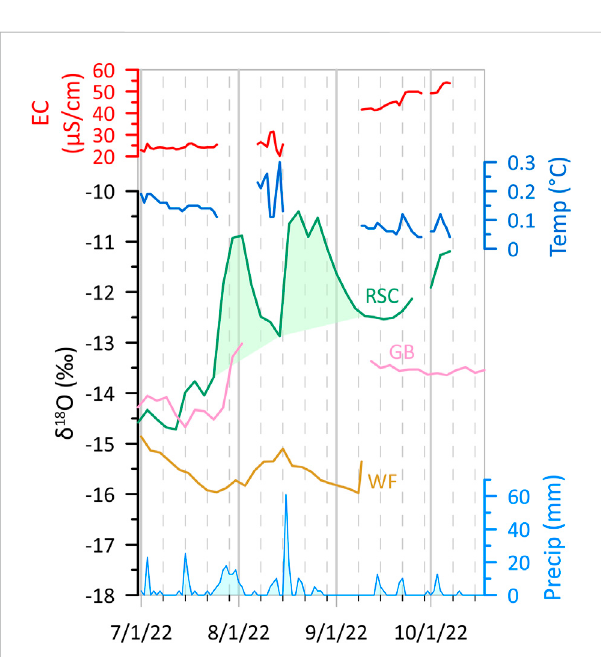
FIGURE 5 Timelineof δ 18 OvaluesfromtheRSC,GB,andWFwatersamplers in the La Sal Mountains through the melt season of 2022. The RSC record, which is themostcomplete,containstwo prominent spikesto less negative values that correspond with precipitation events at the nearby Gold Basin SNOTEL. The GB sampler experienced an error after the start of the fi rst major precipitation event and was dormant until early September. The WF sampler stopped running in early September. Daily electric conductivity (EC) in µS/cm (red line) and water temperature (blue line) at RSC are also presented.